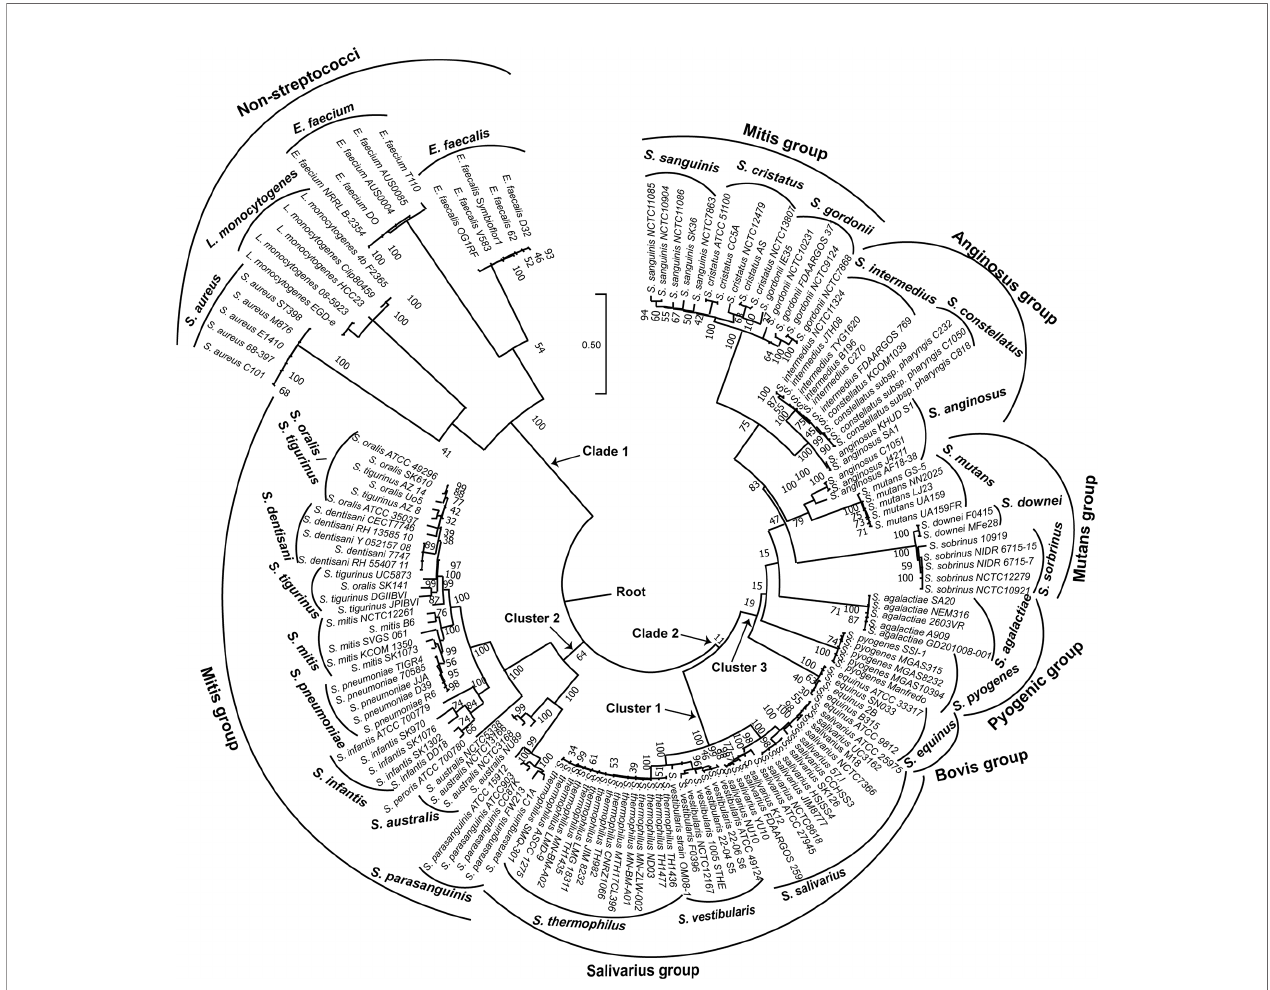
FIGURE 2 | Maximum likelihood phylogenetic tree based on the coaE gene sequence of 154 bacterial genomes (134 streptococcal and 20 non-streptococcal genomes). The tree was rooted using the non-streptococcal clade (clade 1) as an outgroup. Tamura 3-parameter was used as substitution model with a discrete gamma distribution of invariable sites and bootstrap test of 1000